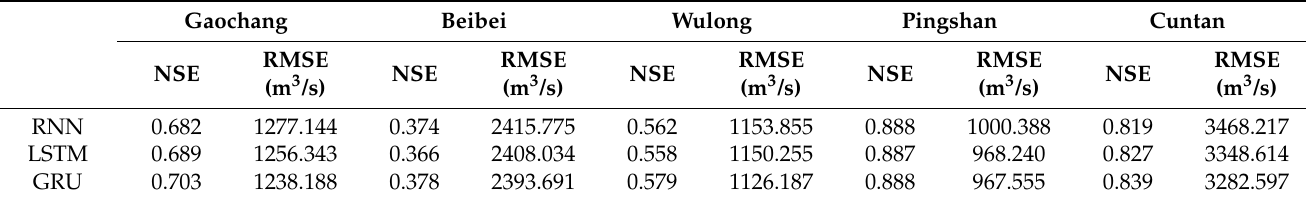
Table 4. The performance of RNN, LSTM, and GRU models at daily runoff prediction with optimal time lag and lead time.